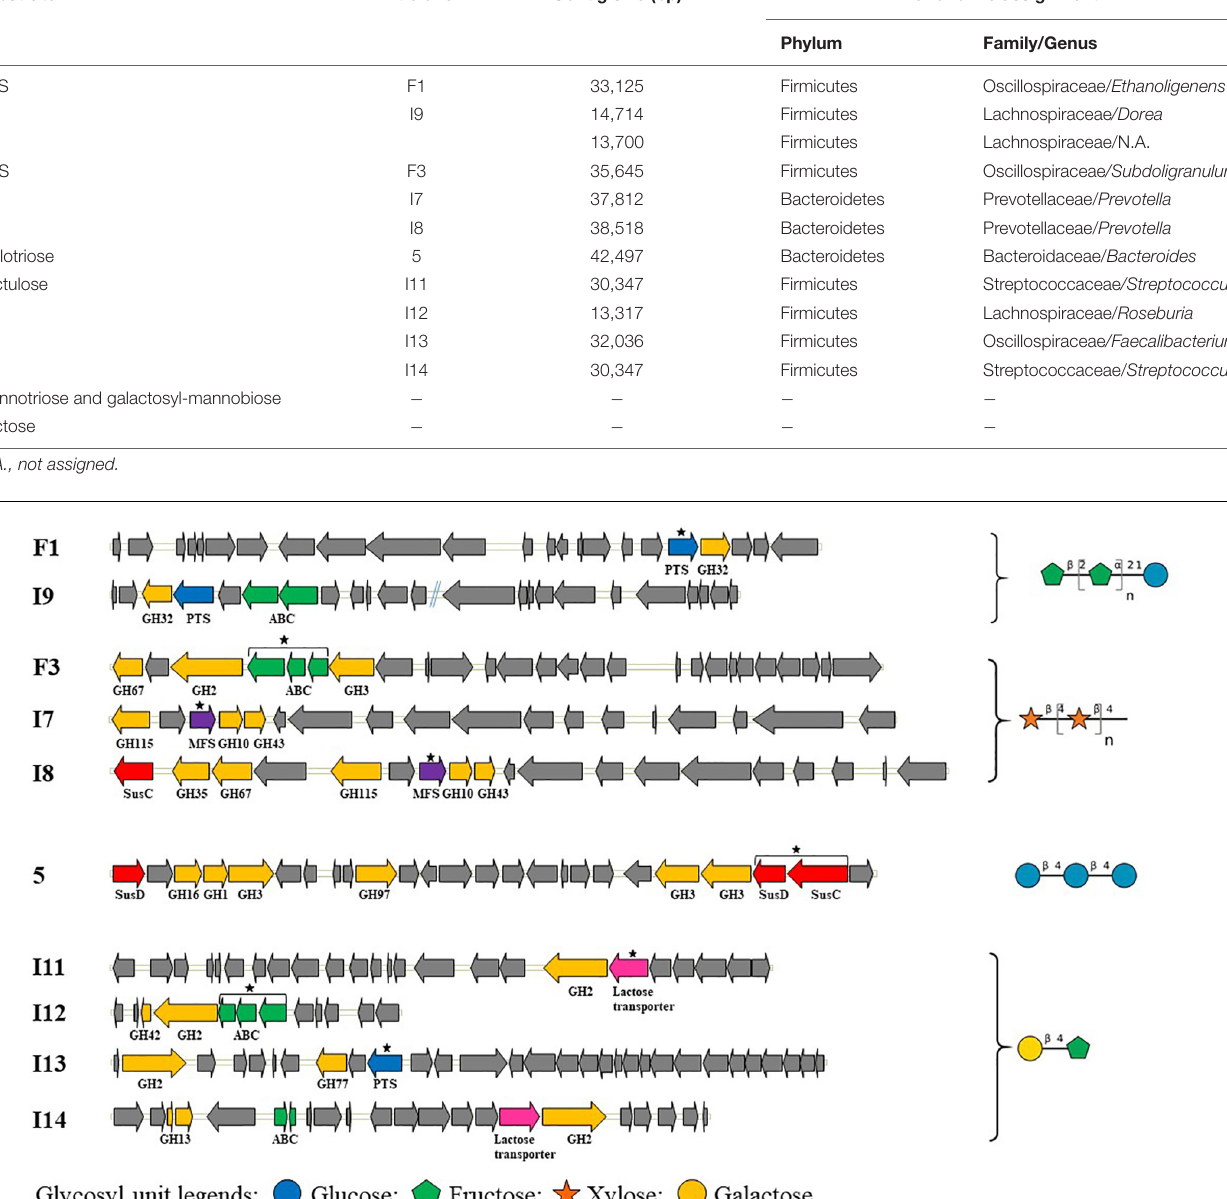
TABLE 3 | Summary of hit clones with the substrate used for growth screening, their contig size and taxonomic assignment at phylum, family or genus. Substrate